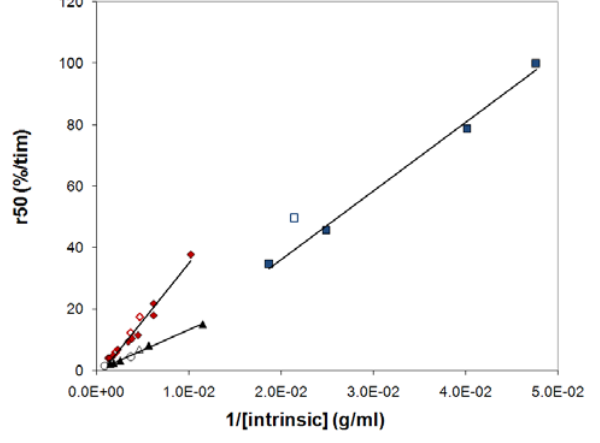
and 1/[ η ] for PEO (red diamonds), Figure 9. Comparing the relationship between r 50 dextran (blue squares), HPMC60SH (black triangles) and HPMC90SH (black circles). Filled symbols represent samples in the mixing series, unfilled symbols nonmixed samples. The lines are linear fits to data for the mixed samples, and are included as a guide for the eye.